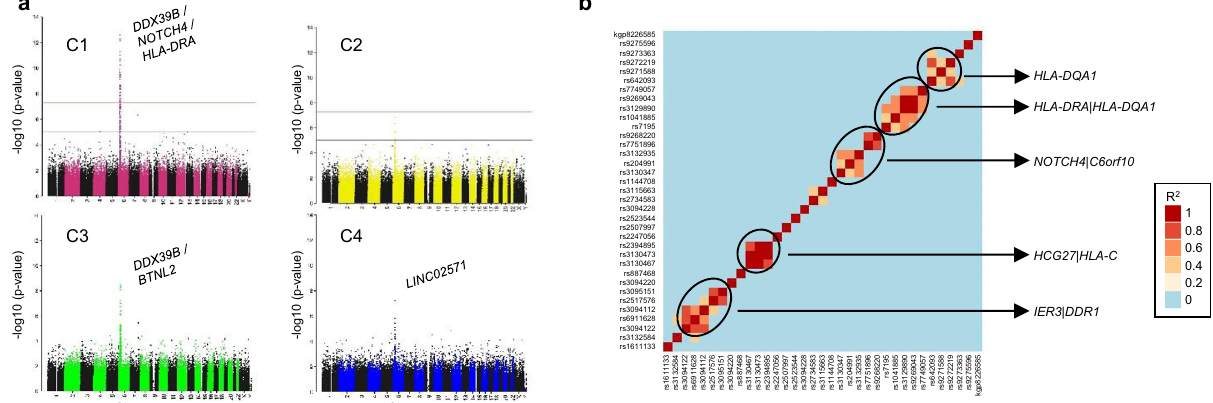
Fig. 4 Cluster genome-wide association analyses (GWAS). GWAS analysis was performed using Plink, an open-source whole genome association analysis toolset, using a logistical regression for 304 pSS (C1: 101, C2: 77, C3: 88 and C4: 38) patients and 330 healthy volunteers (HV) and each cluster was compared to HV. a Manhattan plots for each cluster are shown. b Linkage disequilibrium analysis in the loci of the 35 SNPs detected in C1 and located on chromosome 6 from base 29809362 to base 32681631. The R 2 correlation coef fi cient and linkage disequilibrium heatmap were obtained with Plink, and oncofunco R package, respectively. Strongest associations between SNPs are